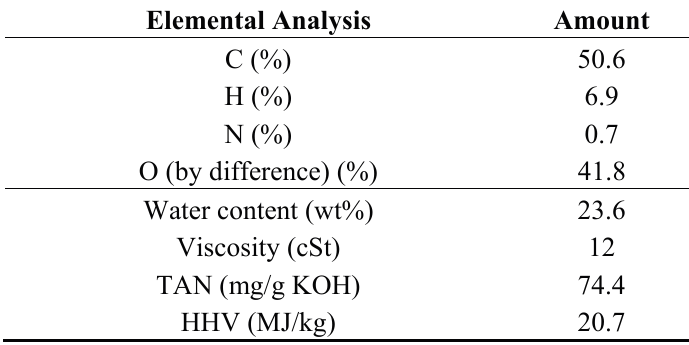
Table 1. Physical properties of Japanese red pine sawdust bio-oil